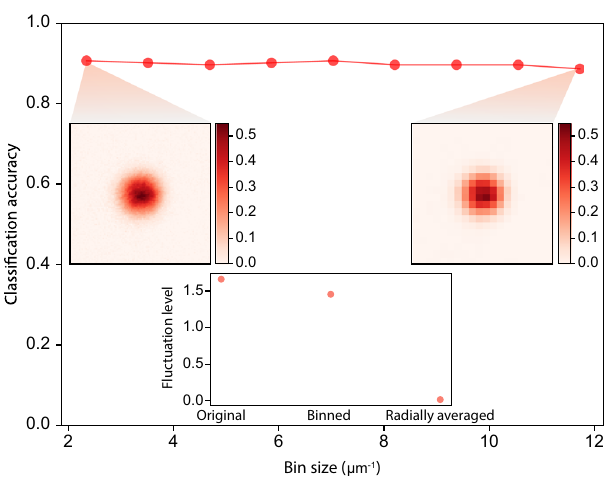
Fig. 5 Classi fi cation accuracy with different bin sizes. The classi fi cation accuracy is quite robust when bin size n is changed from 2.3 to 11.70 μ m − 1 . The inset shows the comparison of fl uctuation level among the original image, binned image, and radially averaged